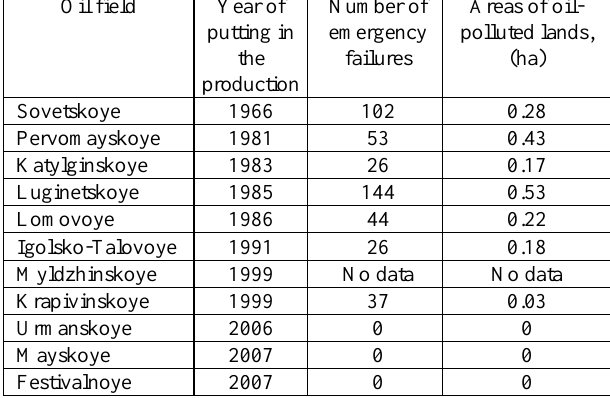
Table 1. Number of emergency failures and areas of oil-polluted lands in the oil fields of Tomsk region in